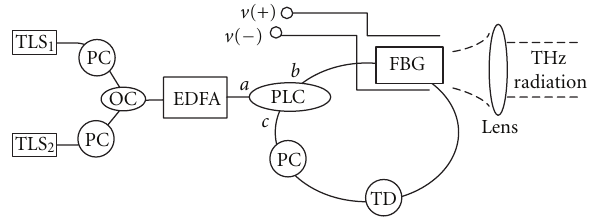
Figure 3: The structure of the proposed THz generation system.